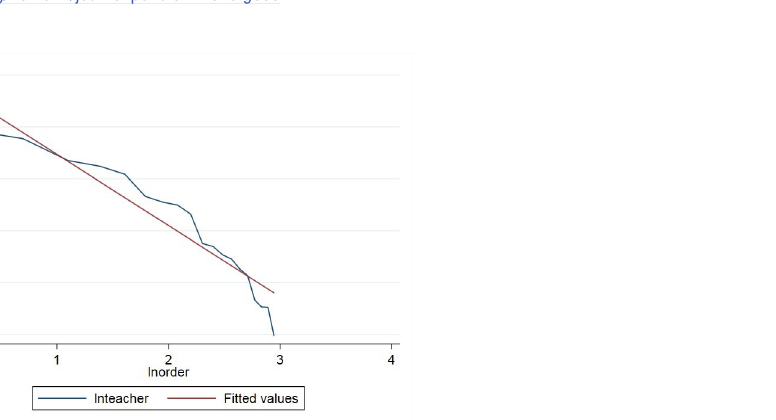
Fig 3. The distribution curve of full-time teacher numbers for different education categories in China from 2003– 2014 (Unit: Quantity).